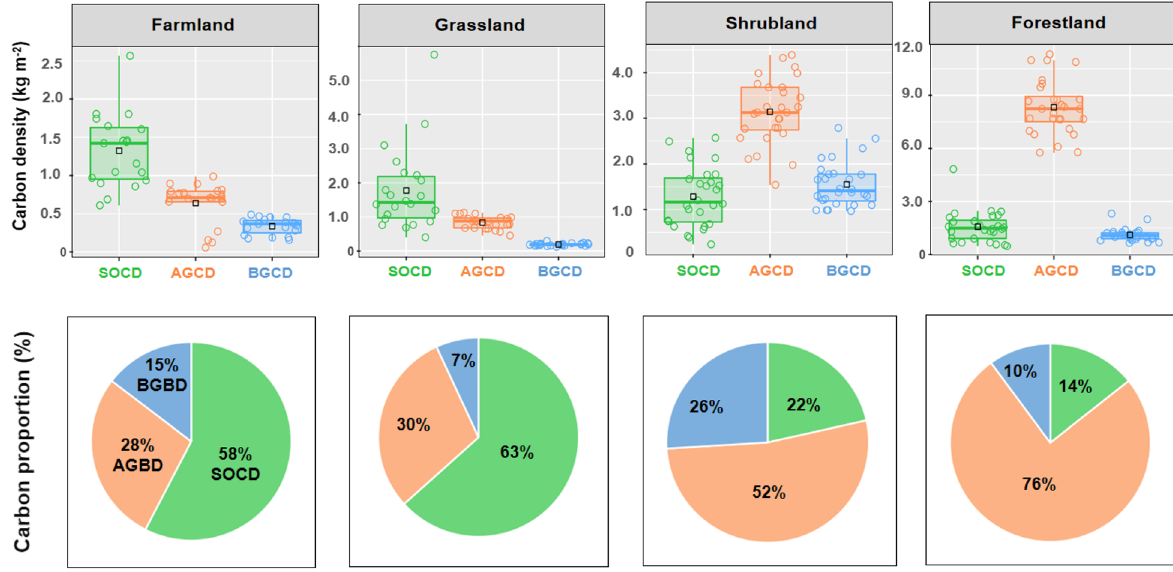
Fig. 5 Box plots show the C density in above-ground, below-ground and soil in farmland, grassland, shrubland, forestland. The lower and upper boundaries of the box represent the first and third quartiles, respectively; the horizontal line represents the mean; the bounds of the lower and upper bars reflect the 10th and 90th percentiles, respectively. The proportion of above-ground carbon density (AGCD), below-ground carbon density (BGCD) and soil organic carbon density (SOCD) in the ecosystem total carbon density (ETCD) in farmland, grassland, shrubland,